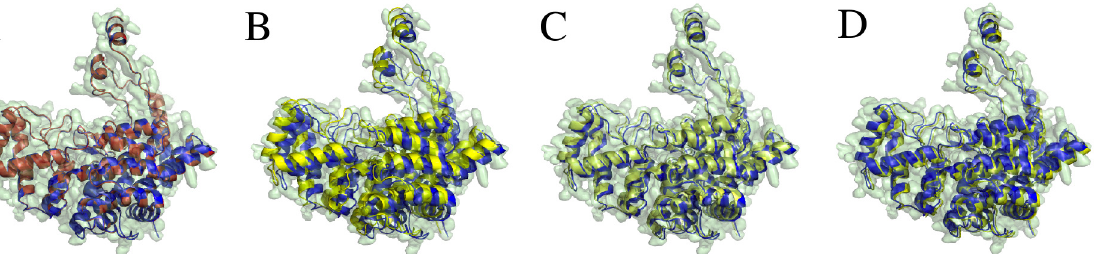
Fig 3. Comparison of PF 2 fit with other software in synthesized EM fitting at 3 Å . A molecule is fitted into the synthetically generated EM map B with resolution 3 Å (transparent green). The top-ranked result P 1 (red/yellow) is compared to the original PDB molecule P (blue). (A) Top-ranked result using PF 2 fit — SE(3) with 8° uniform rotational sampling and 0.5 Å translational step size. RMSD (cid:5) 0.88 Å . (B) Top-ranked result using the Colores package; the ‘ nopowell ’ option is turned on. RMSD (cid:5) 3.2 Å . (C) Top-ranked result using Colores with default options. RMSD (cid:5) 2.3 Å . The fitted PDB P 1 is in yellow. (D) Top-ranked result using the ADP_EM package, with bandwidth L = 25. RMSD (cid:5) 0.94 Å .